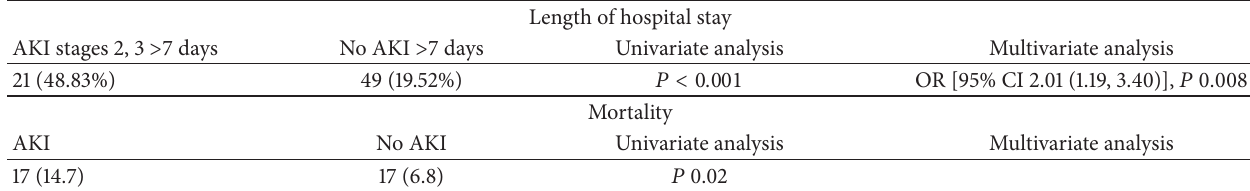
Table 4: Impact of AKI on hospital stay and mortality.